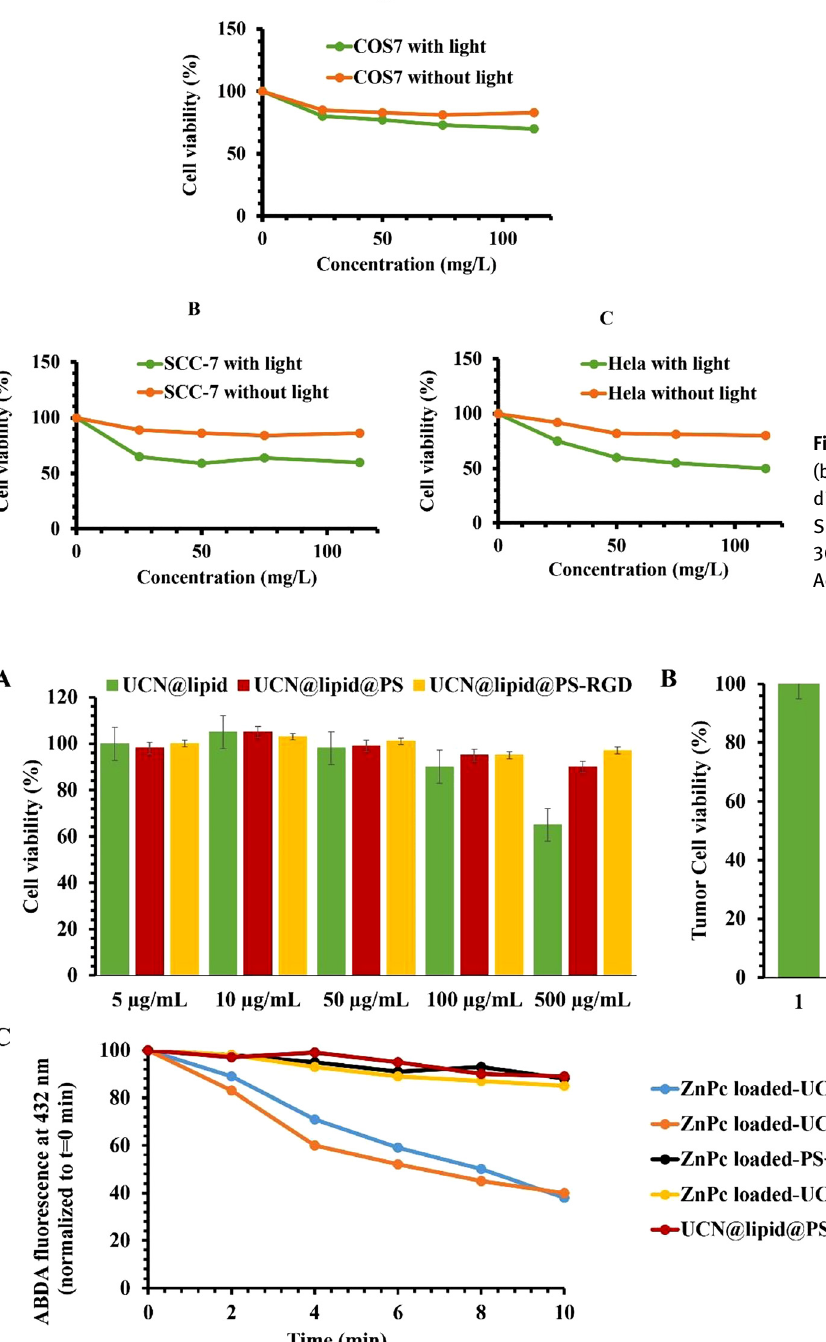
Figure 12: (A) Cytotoxicity on Hela cells of UCN@lipid, UCN@lipid@PS, and UCN@lipid@PS-RGD. (B) Viability of Hela cells treated with 1 PBS (Control group), 2 UCN@lipid@PS nanodumbbells plus NIR laser, 3 ZnPc loaded-PS NPs plus NIR laser, 4 (ZnPc + UCN@lipid)@PS NPs, 5 (ZnPc + UCN@lipid)@PS NPs plus NIR laser, 6 (ZnPc + UCN@lipid)@PS-RGD NPs plus NIR laser (980 nm, 1.5 W cm − 2 ). The concentration is 500 μ g mL − 1 . (C) Comparison of 1 O 2 production between control groups and experiment groups. Adapted from Hou et al.